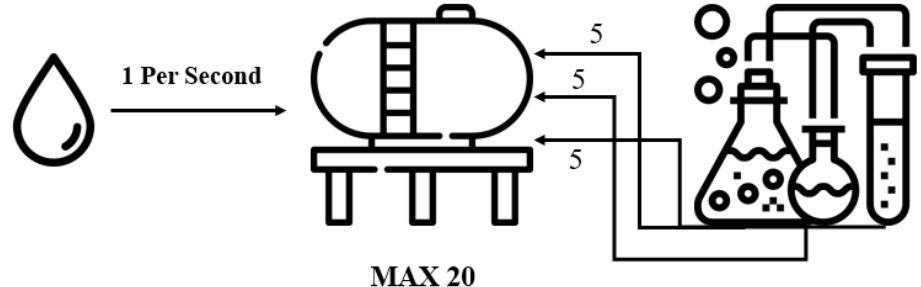
Figure 7. Water intake and chemical treatment phases.